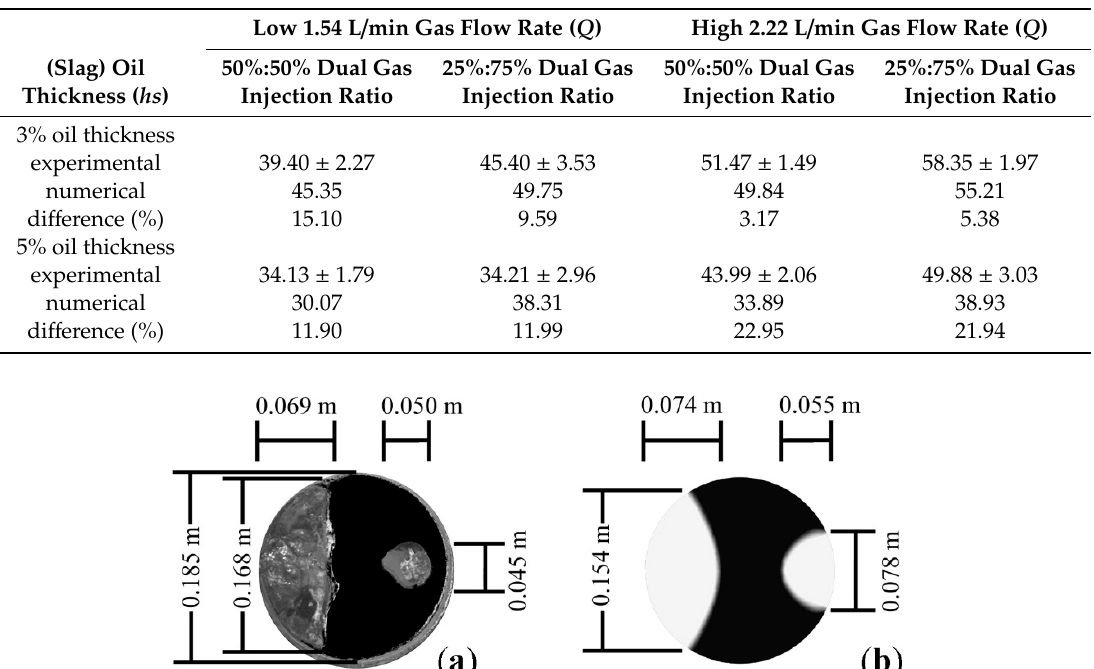
Table 5. Slag eye area as a percentage of the total surface area for di ff erent operating conditions experimentally obtained through image analysis from both experimental and numerical models.